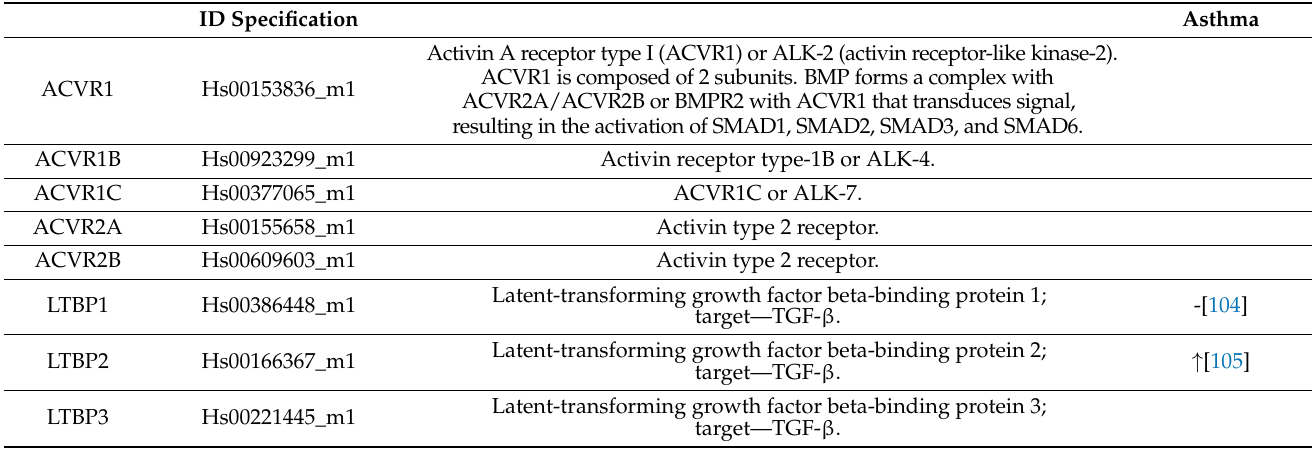
Table A2. A brief review of the functions and sources of TGF- β signaling pathway